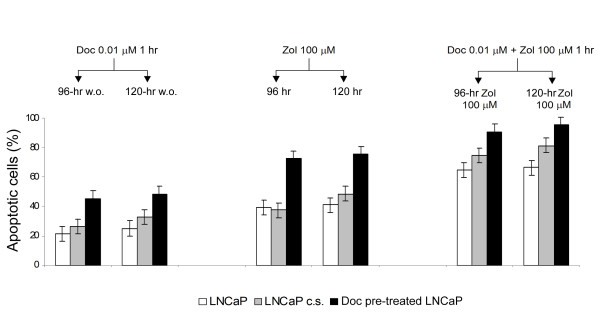
Apoptotic cells (%) measured by Ann-V assay in LNCaP line grown in normal medium (white bars), charcoal-stripped (c.s.) hormone-deprived medium (grey bars) and normal medium after taxane pre-treatment (black bars). Cells were analyzed after a 1-h exposure to Doc 0.01 μM followed by a 96- or 120-h w.o. (left histogram bars), after a 96- or 120-h continuous exposure to Zol 100 μM (center histogram bars), and after exposure to the Doc-Zol combination (right histogram bars). The percentage of apoptosis in untreated cells never exceeded 10%. Error bars represent the mean standard deviation.